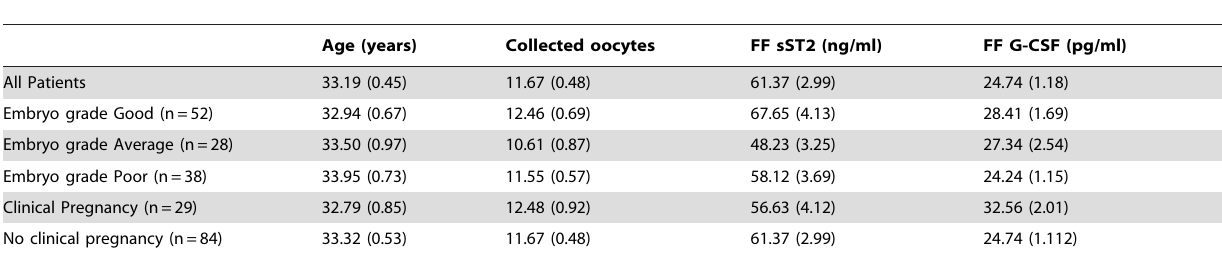
Table 2. Patient characteristics for women recruited to Lie`ge University. Values are Mean (S.E.M.).